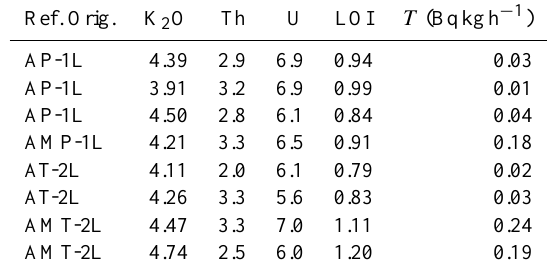
Table 2. Chemical and radiological properties of several samples from different facies of the bluish granites. LOI: Loss On Ignition in%; K 2 O in%; Th and U in ppm; T : Rn exhalation. Detection limits were 0.5ppm for Th, 0.5ppm for U and 0.11ppm for K 2 O. Ref. Orig.